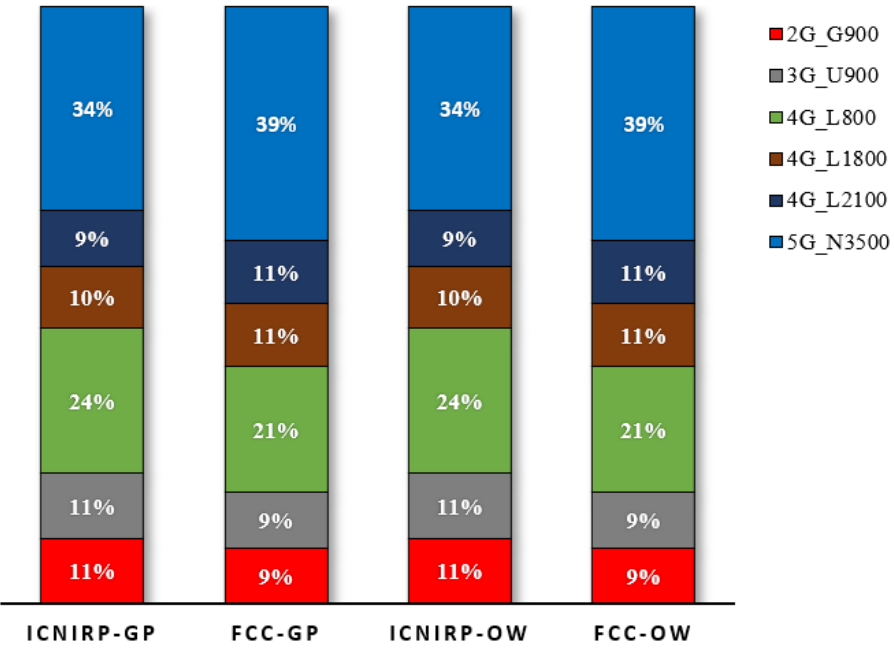
Figure 8. The EMF radiation contribution at the R CD in the horizontal direction for the macro site shared by 4 MNOs.